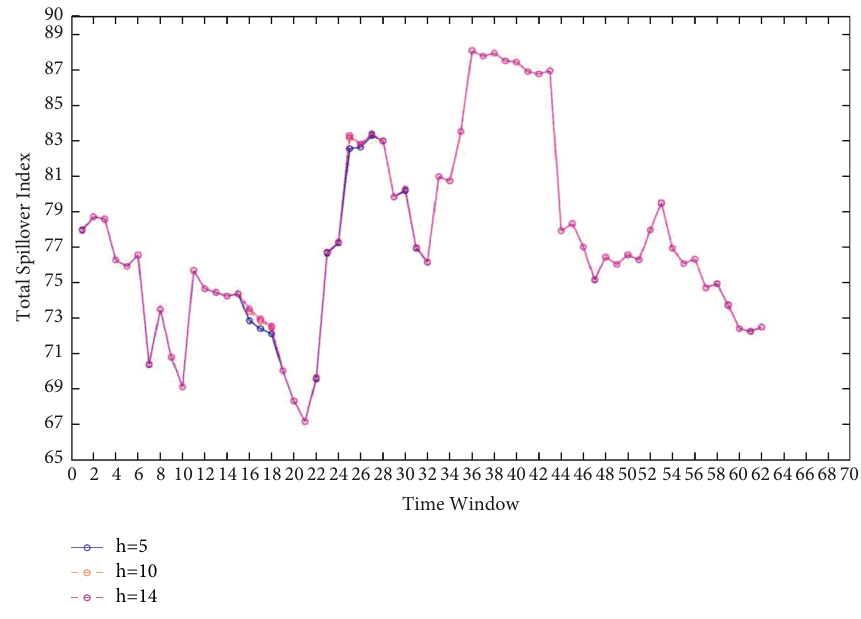
Figure 6: Total spillover index (return spillovers).